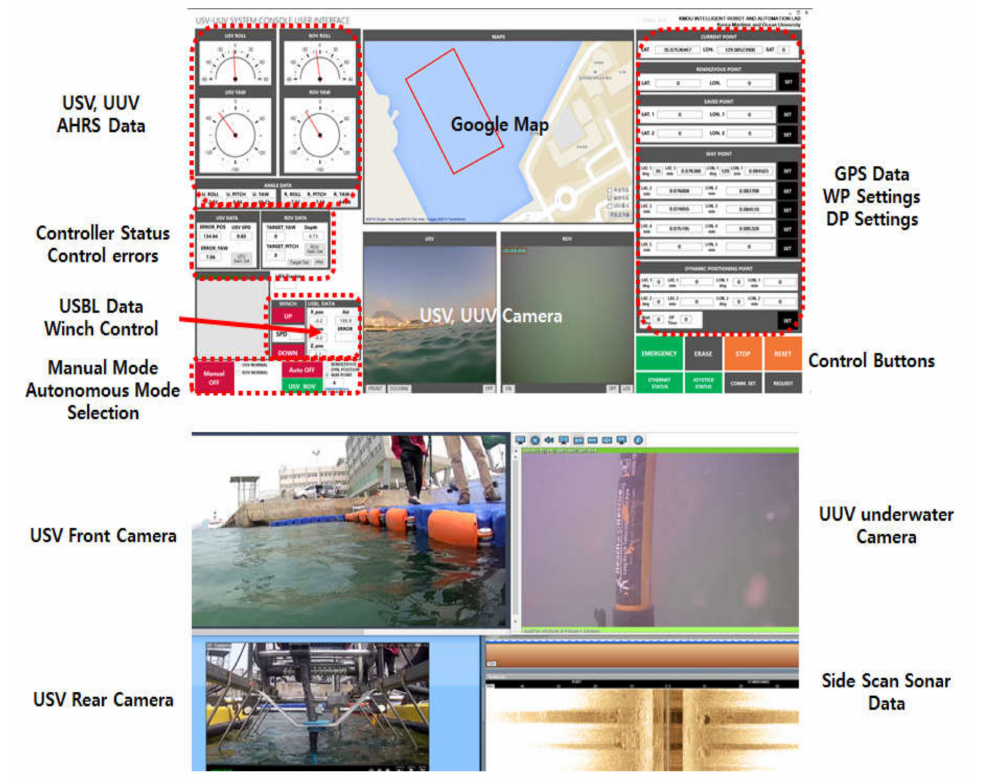
Figure 15. Operation program for the integrated